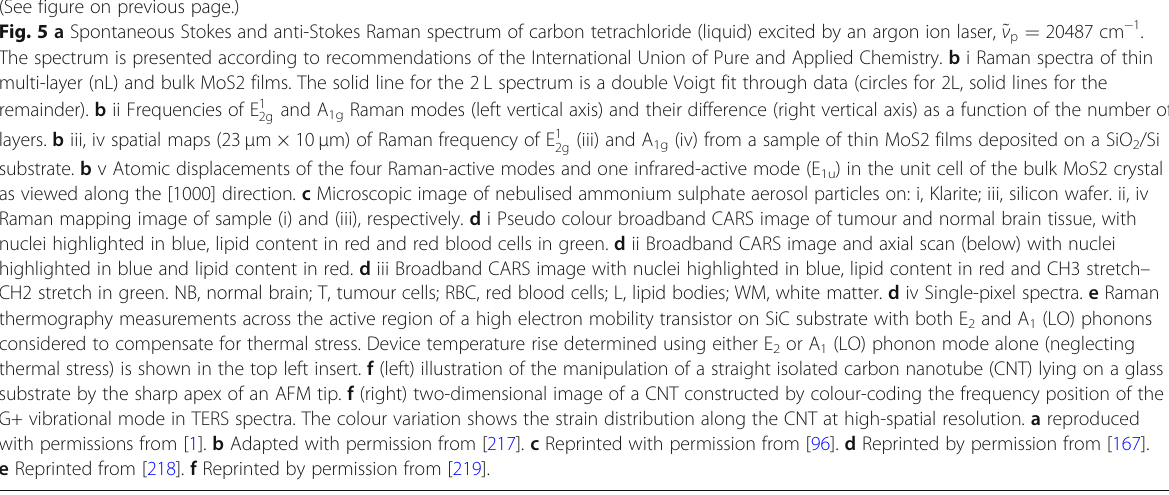
small spots yield a signal at the ~ ν s (SO 42 − ) Raman